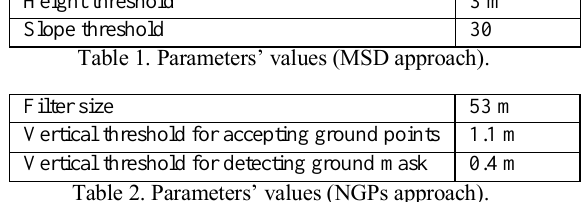
Table 2. Parameters’ values (NGPs approach).